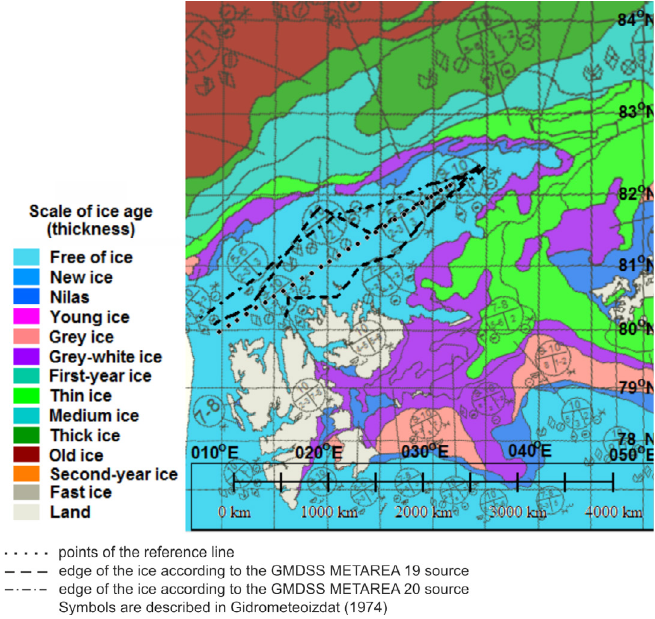
Fig. 1. Map of sea ice of the ESIMO